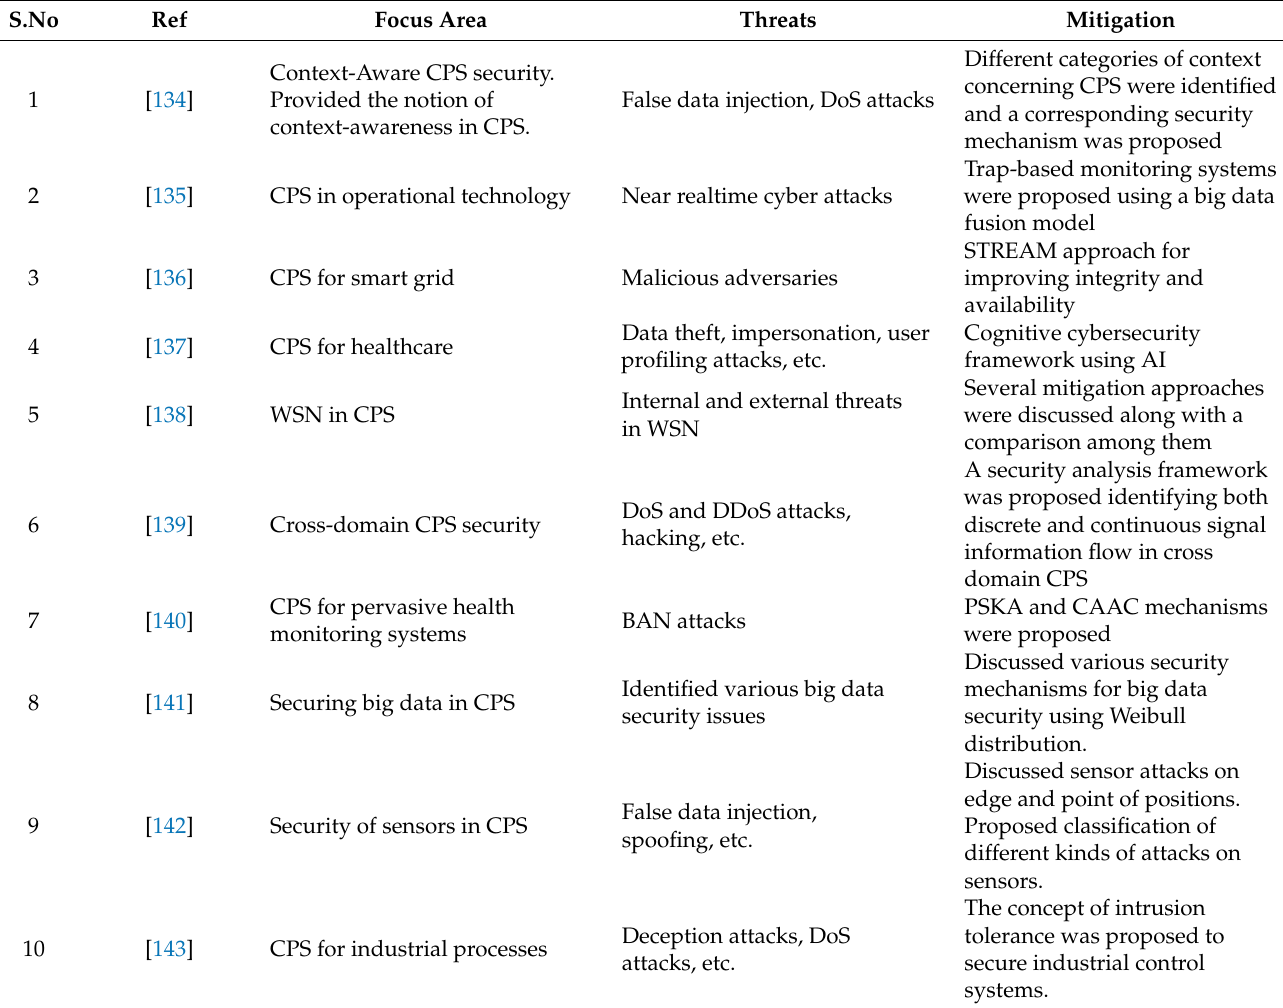
Table 2. Security Attacks in